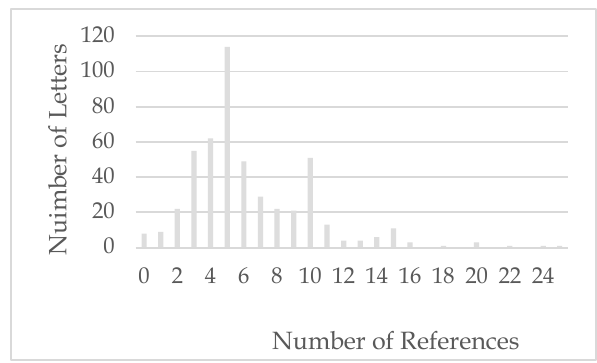
Figure 3 Number of Authors per Letter*